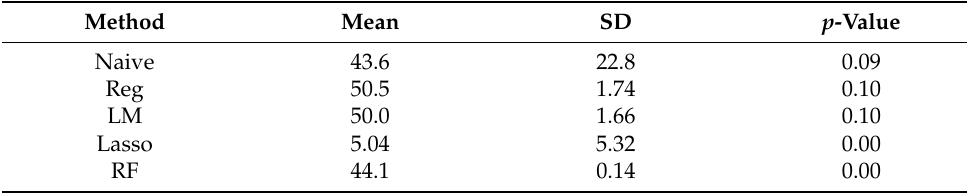
Table 3. Summary results for ATE true = 50, non-linear.